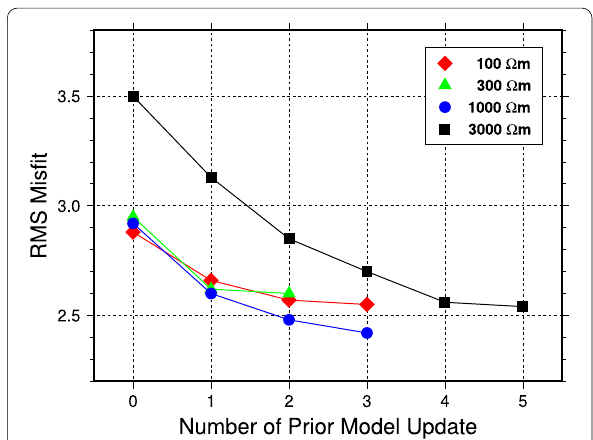
Fig. 3 RMS misfit change in terms of prior model update. Each line and character shows RMS misfit change depending on initial prior model (see text). Initial prior model is represented by uniform